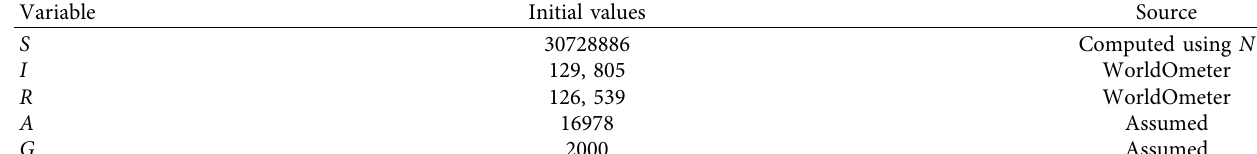
Table 4: Initial values for S , I , R , A , and G .